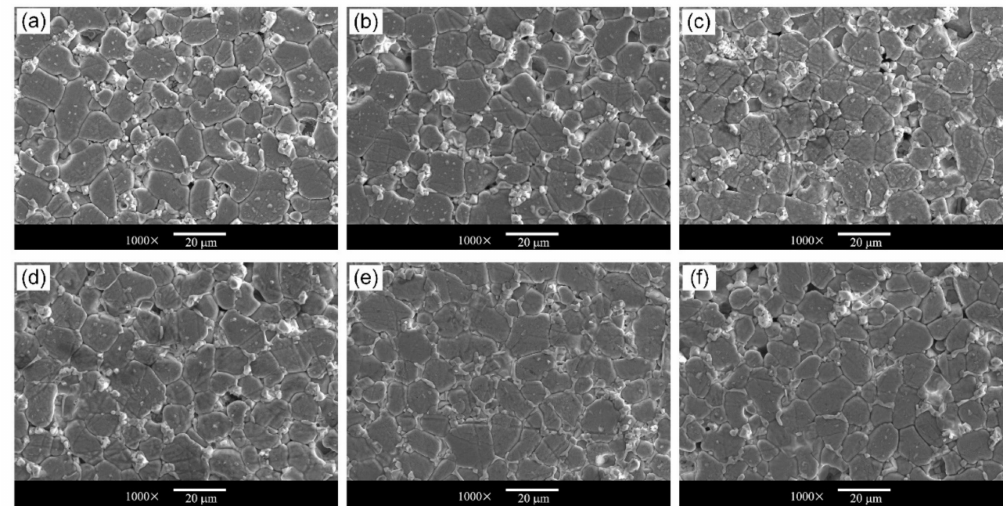
Figure 2. SEM pictures of ZnO ceramic samples of Q-1200-2h ( a ), Q-1000 ( b ), Q-800 ( c ), Q-600 ( d ), Q-400 ( e ) and as-prepared samples ( f ).